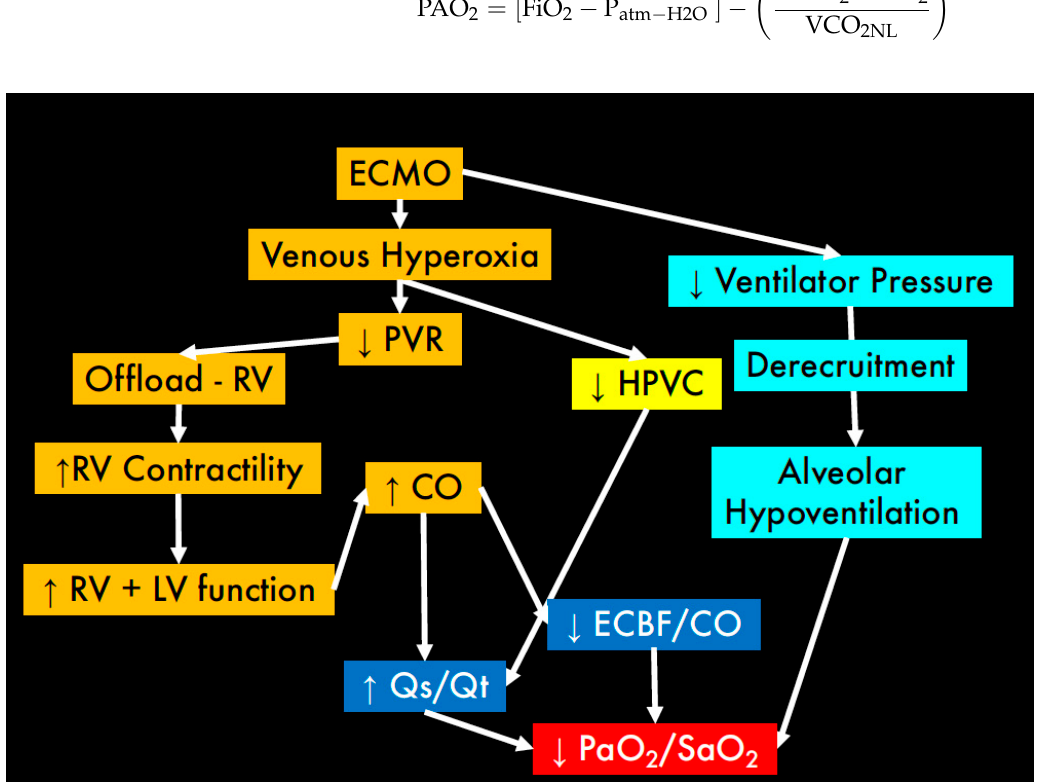
Figure 4. ECMO initiation. The delivery of VV-ECMO optimises oxygenation and allows a reduction of mechanical power delivered to the lungs. ECMO produces venous hyperoxia which in turn reduces pulmonary vascular resistance and hypoxic pulmonary vasoconstriction. This improves right ventricular function and cardiac output. A consequence of this physiological change is a larger shunt fraction in the native lung and a lower ECBF/CO ratio, both resulting in a lower arterial oxygen tension. This is further compounded by “lung rest” strategies leading to progressive de-recruitment and alveolar hypoventilation. In order to maintain adequate oxygenation ECBF may need to be increased to re-balance this ratio.